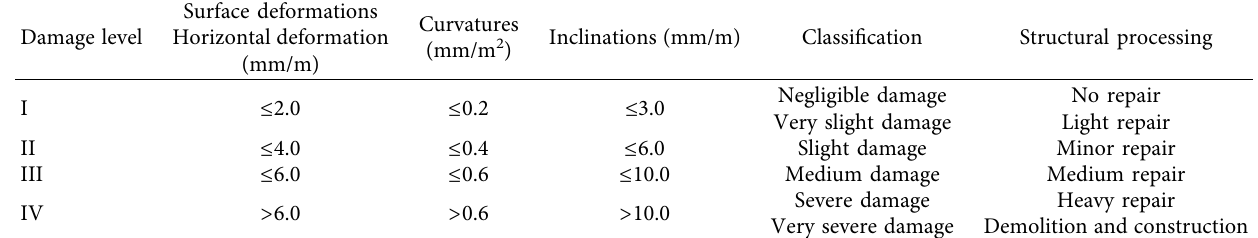
Table 1: Classification of damage to surface brick-concrete structures [16].